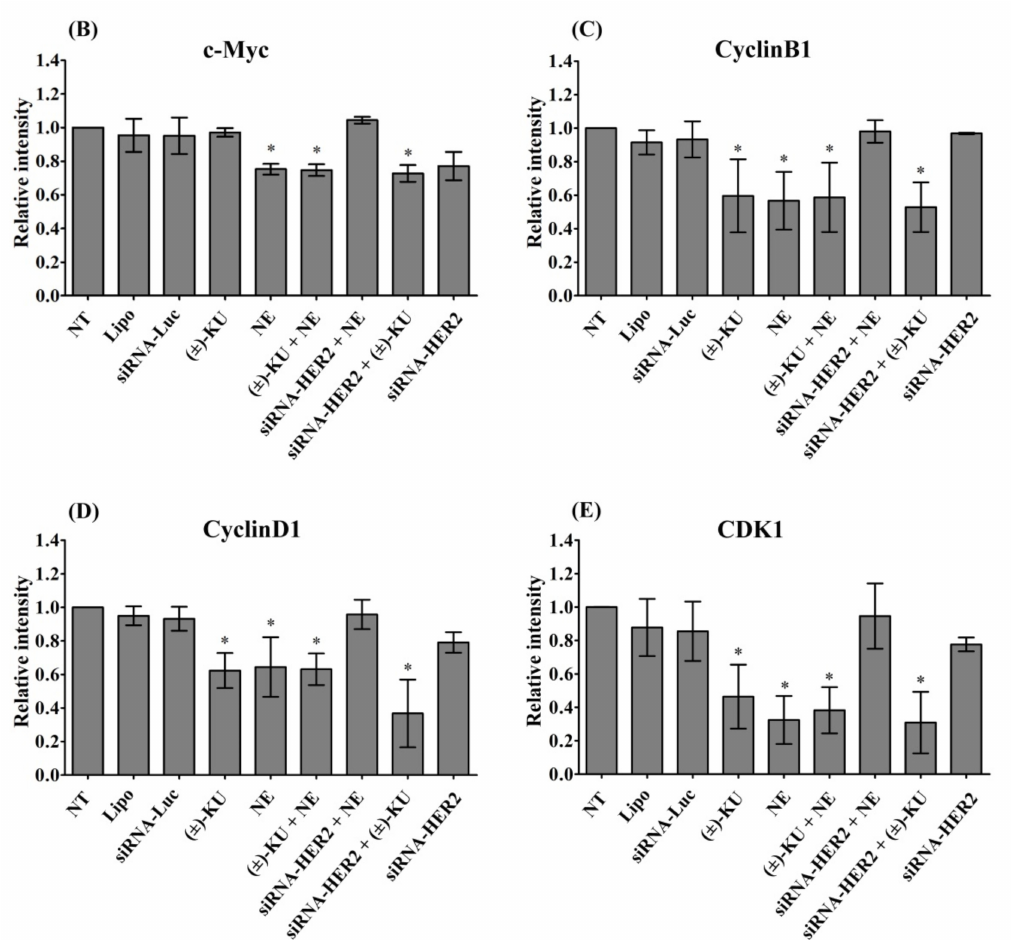
Figure 7. Effect of synthetic ( ± )-kusunokinin on cell proliferation proteins. MCF-7 cells were treated with synthetic ( ± )-kusunokinin (4.45 µ M), neratinib (0.004 µ M), a combination of synthetic ( ± )-kusunokinin and neratinib, or 100 nM siRNA-HER2 for 48 h. For the combination of siRNA with compound, cells were incubated with 100 nM of siRNA-HER2 for 24 h followed by treatment with 4.45 µ M ( ± )-kusunokinin, or 0.004 µ M neratinib for 48 h. The negative controls were non-treated cells, lipofectamine and siRNA-luciferase treatments. ( A ) After incubation, cells were harvested and lysed by RIPA buffer. Total protein was subjected to SDS-PAGE and proteins of interest were determined using West- ern blot analysis. GAPDH served as an internal control. The quantitative proteins of interest, including ( B ) c-Myc, ( C ) CyclinB1, ( D ) CyclinD1, and ( E ) CDK, were calculated by normalized with GAPDH band intensity. Data are represen- tative of three independent experiments. All graphs show mean ± S.D. The student’s t -test was used for consideration of p values < 0.05. * p < 0.05 vs control. NT, non-treated cells; Lipo, lipofextamine; siRNA-Luc, siRNA-Luciferase; KU, ( ± )-kusunokinin; NE, neratinib; KU+NE, ( ± )-kusunokinin+neratinib; siRNA-HER2+NE, siRNA-HER2+neratinib; siRNA- HER2+KU, siRNA-HER2+( ±